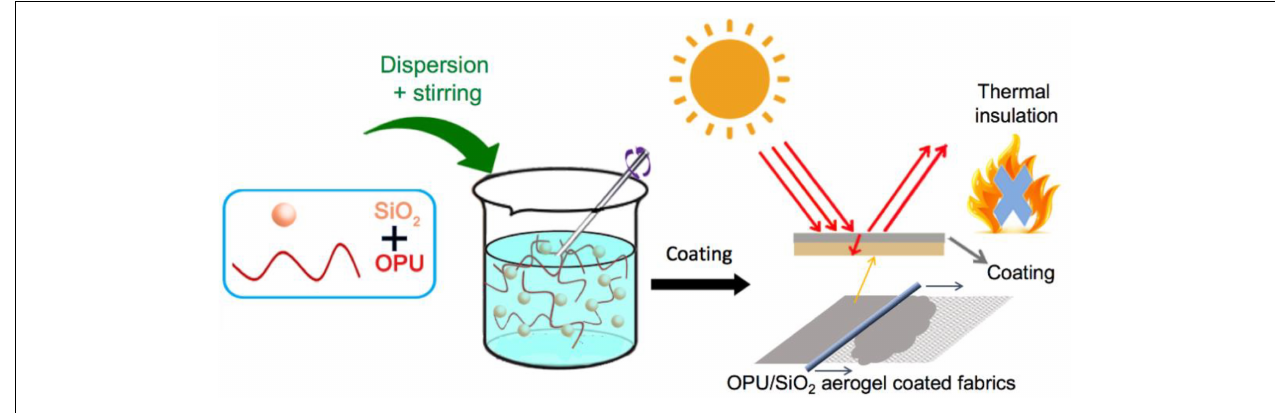
FIGURE 1 | Schematics of the fabrication process of OPU/SiO 2 aerogel coated